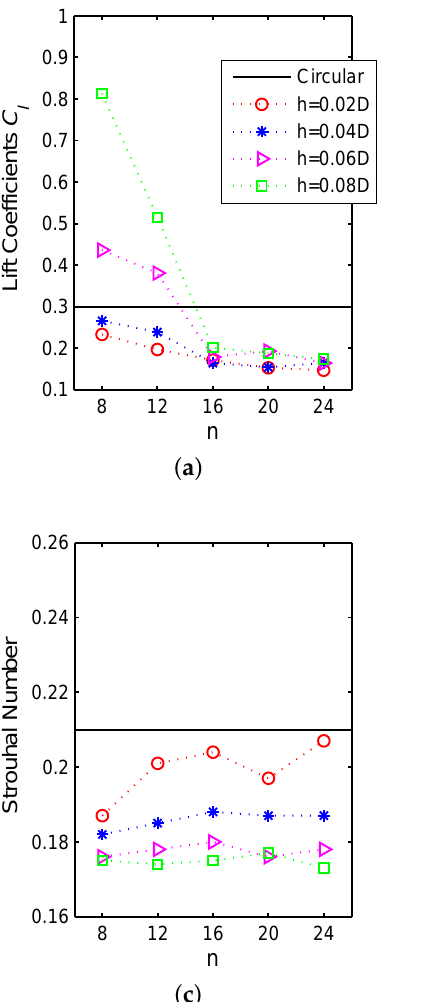
Figure 5. Hydrodynamic coefficients of a stationary cactus-shaped cylinder simulated in a two- dimensional flow field: ( a ) lift coefficients, C l , ( b ) drag coefficients, C d , and ( c ) Strouhal number, S t . The cactus-shaped cylinder, R 8-0.04, having 8 ridges with the height of ridges equals to h = 0.04 D , was used as an example to illustrate the mechanism of the VIV suppression of the cactus-like body shape. As shown in Figure 6, snapshots of contours of the current